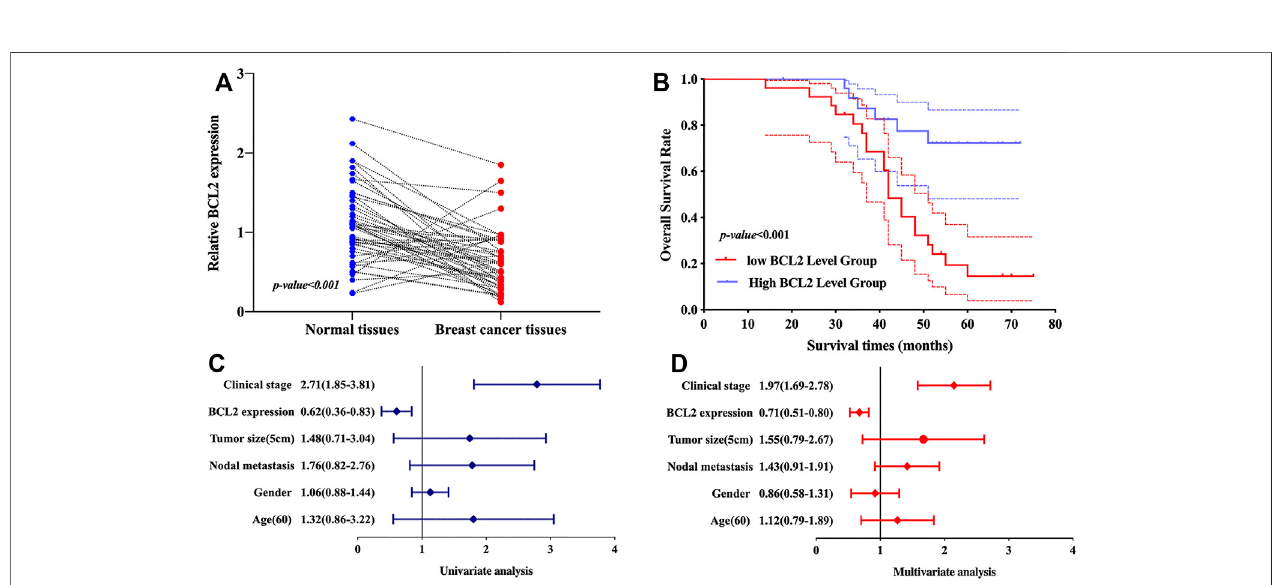
FIGURE8| Validationoftheexpressionand overallsurvivalofBCL1inBRCA. (A) ThemRNAlevelofBCL2 wasdownregulatedinBRCA versus breasttissues. (B) BRCA patients with low BCL2 expression had a poor overall survival. (E – F) Univariate and multivariate analyses demonstrated BCL2 and clinical stage as prognosis factors affecting the OS of BRCA